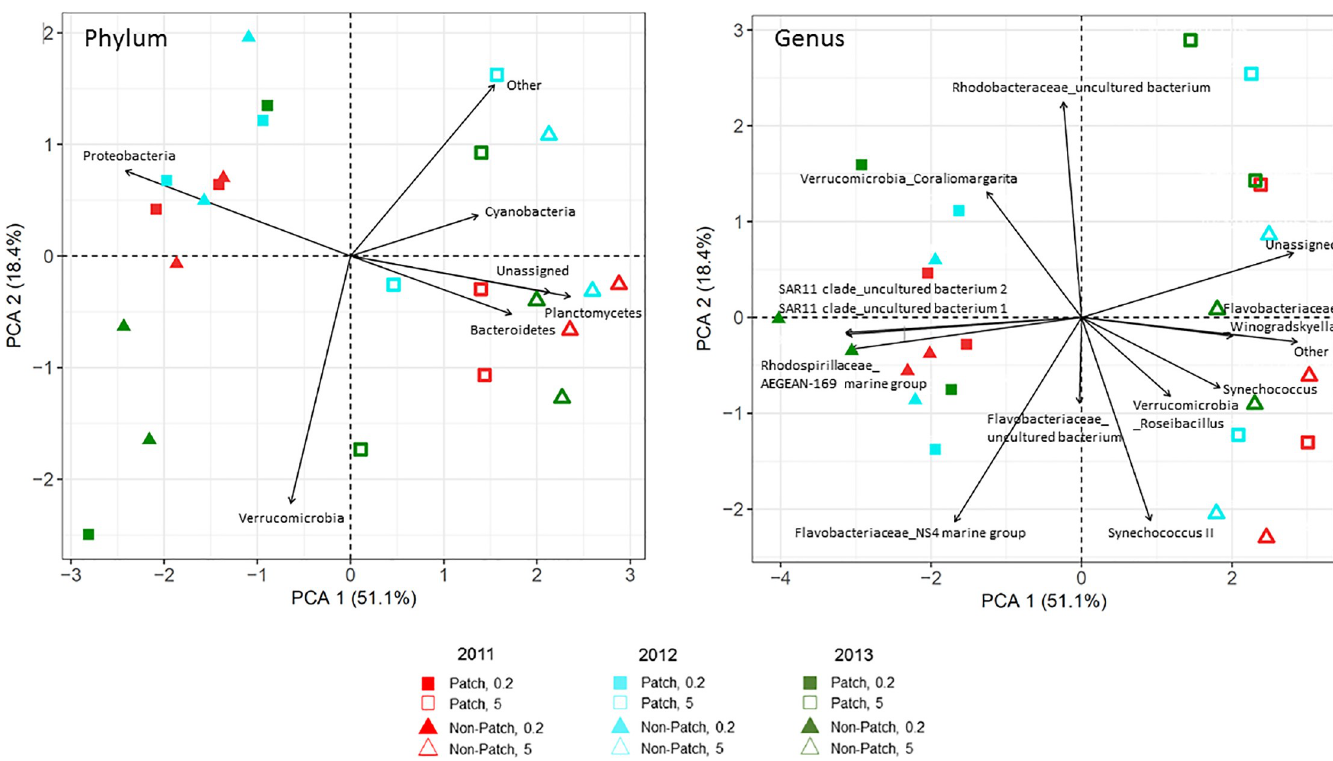
Fig 4. Principal component analyses using Phylum- and genus/species- level Hellinger transformed relative abundances of bacterial sequences from size fractionated ( > 0.2 and > 5 micron) samples collected within and immediately adjacent ( < 10m) to the Cochlodinium bloom patches, designated ‘patch’ (P) and ‘non-patch’ (NP) samples, respectively, for years 2011, 2012 and 2013. Percent variation explained by each principal component is indicated in parentheses.